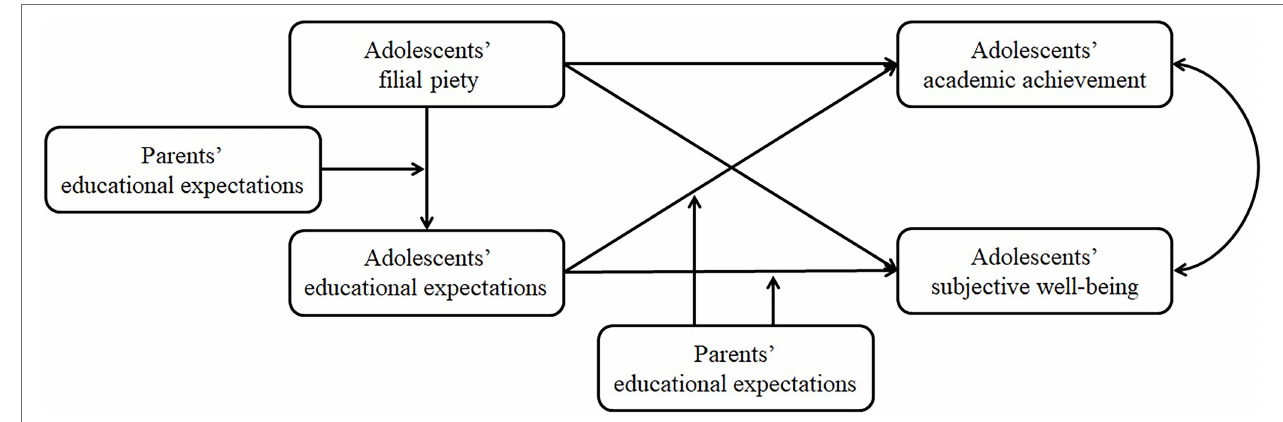
FIGURE 1 | The hypothesized moderated mediation